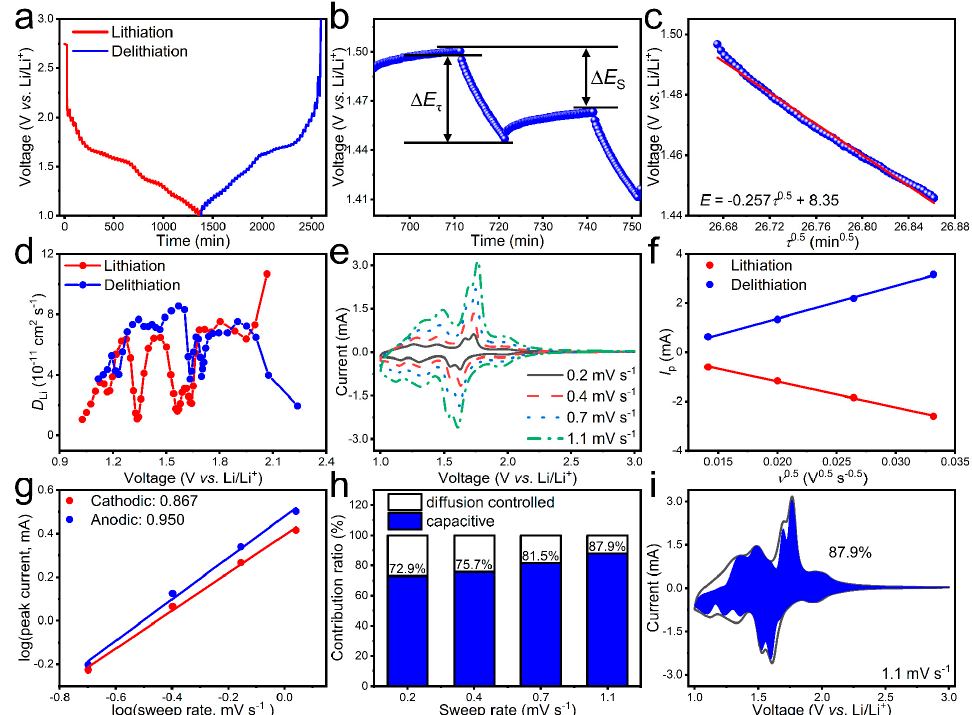
Figure 3. Electrochemical kinetics of C-CuNb 13 O 33 /Li half-cell. ( a ) GITT lithiation/delithiation pro- fi le. ( b ) Potential ( E ) and time ( t ) pro fi le of single step in GITT test. ( c ) Relationship between E and square root of titration duration ( τ 0 . 5 ) during a typical titration. ( d ) Variations of D LiGITT during lithiation/delithiation. ( e ) CV curves at variable sweep rates. ( f ) Relationship between peak current ( I p ) and square root of sweep rate ( ν 0 . 5 ) for intensive cathodic/anodic peaks. ( g ) Calculations of b values through the relationship between I p and ν . ( h ) Pseudocapacitive contribution ratios at different sweep rates. ( i ) Pseudocapacitive contribution ratio at 1.1 mV s − 1